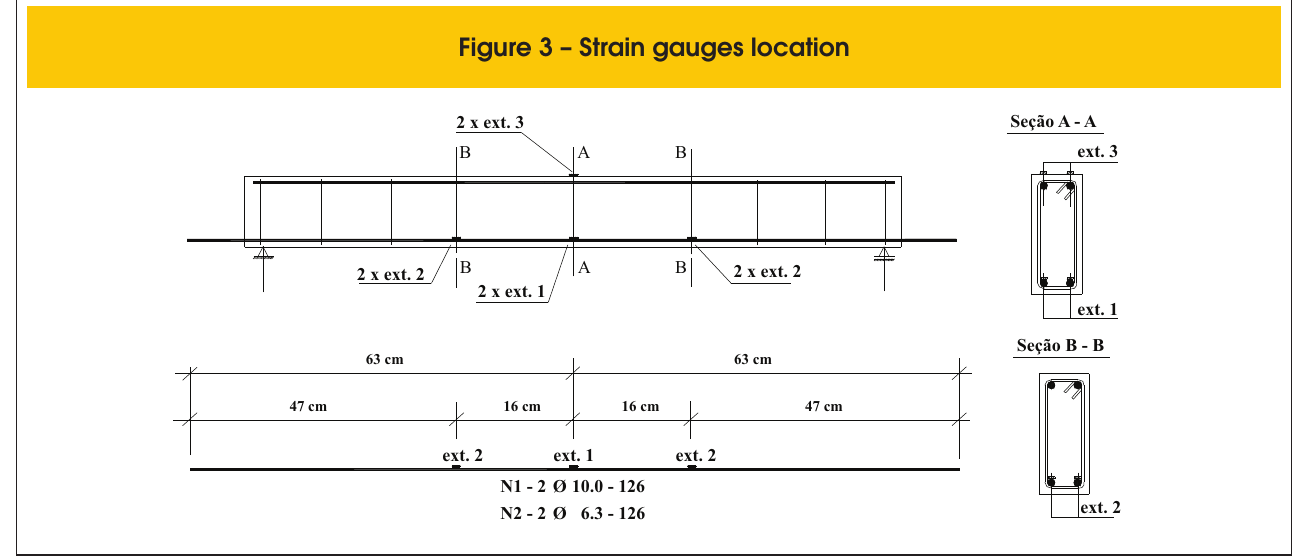
Figure 3 – Strain gauges